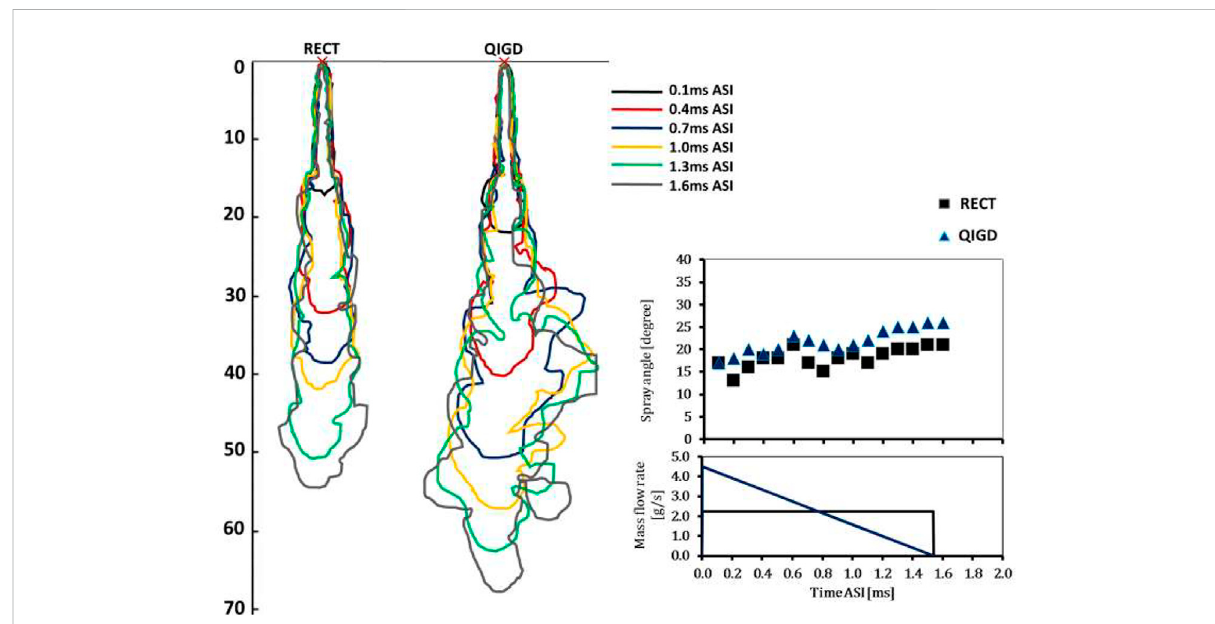
FIGURE 11 Comparisons of spray area boundaries and spray angle of RECT and QIGD.